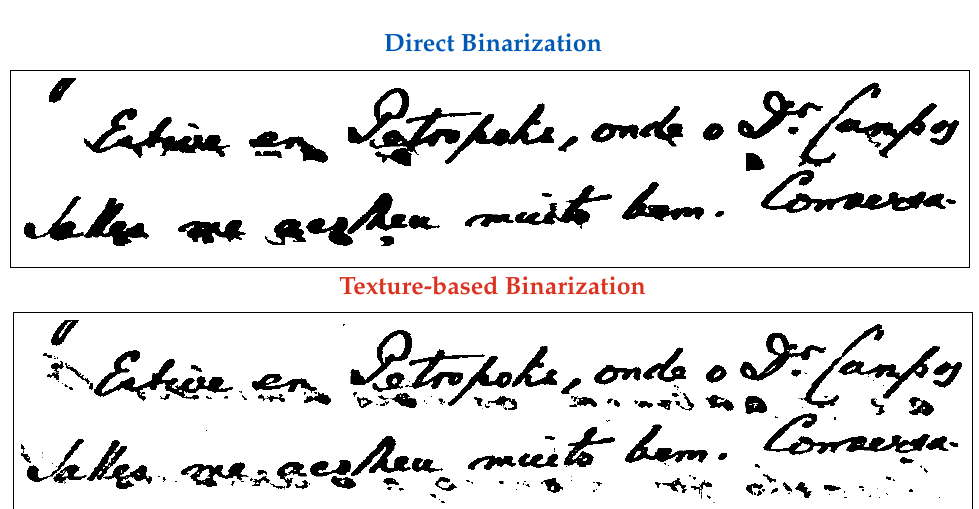
Figure 5. Zoom in a part of a document image HW 05 with strong back-to-front interference binarized using the direct (Jia-Shi [38]) and texture-based (Wolf [72])